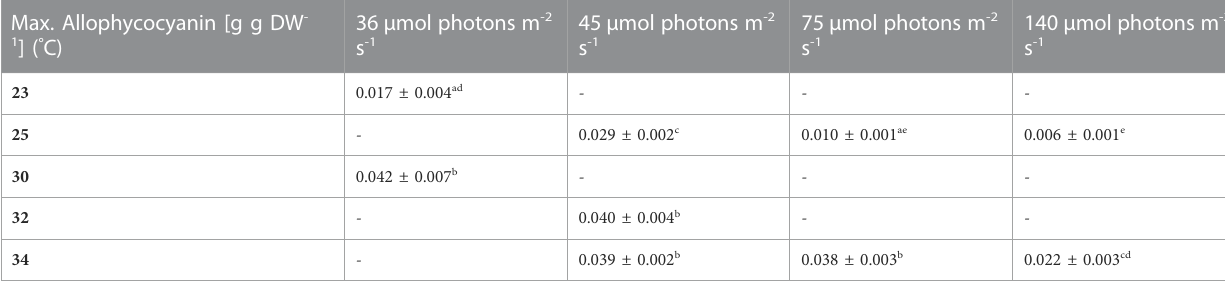
TABLE 8 Maximum allophycocyanin content, the values are shown as mean ± SD of four to eight cultures. Max. Allophycocyanin [g g DW - 1 ] ( ° C)